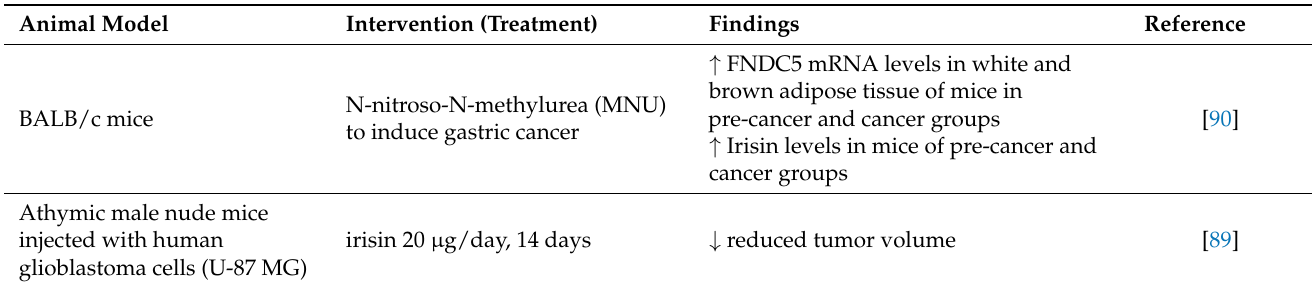
Table 2. Role of Irisin in cancer: in vivo evidence from animal studies.